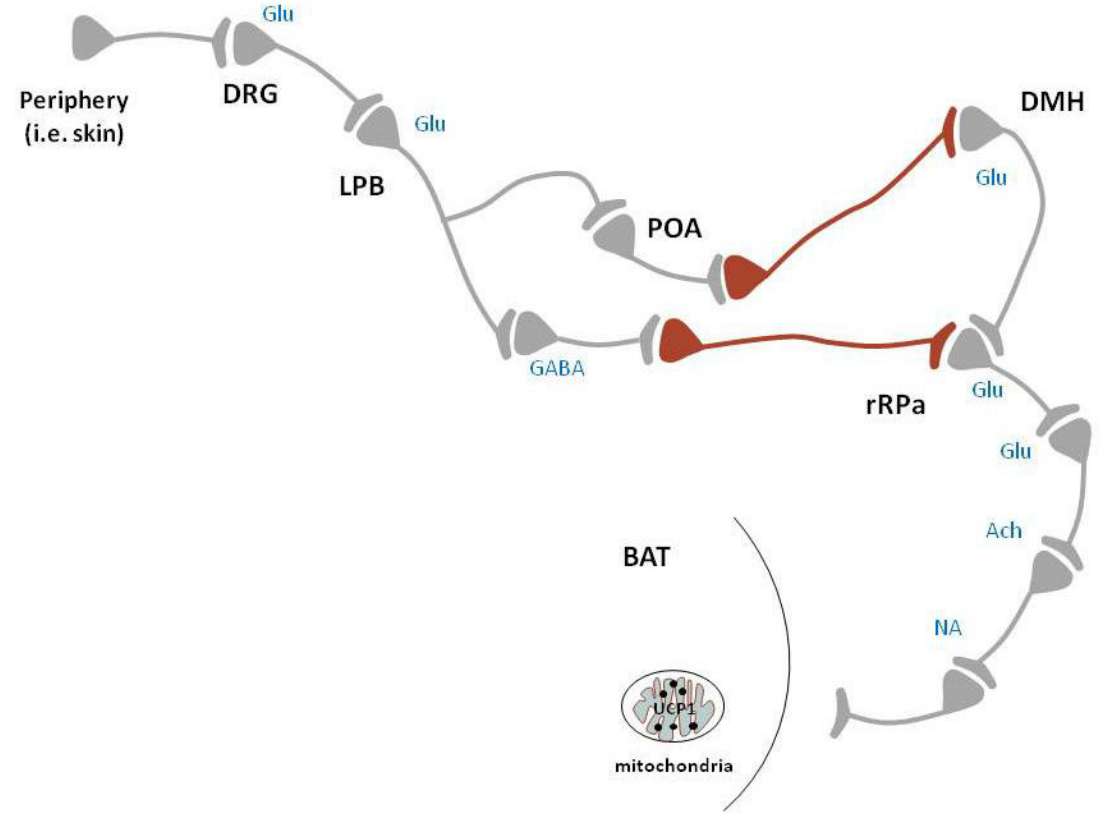
FIGURE 4. Schematic representation of the neuronal pathways involved in temperature regulation and the fever response. Cold-, warm-, and pyrogen-sensitive GABAergic projection neurons (highlighted in red) are part of a neuronal pathway that receives information about peripheral temperature and can regulate fever response by activating thermogenesis in BAT via UCP1. These neurons show the same changes in activity upon cold signals and pyrogens. Abbreviations: BAT, brown adipose tissue; DMH, dorsomedial hypothalamus; DRG, dorsal root ganglion; LPB, lateral parabrachial nucleus; POA, preoptic area, rRPA, rostral raphe pallidus. Glu, glutammate; GABA, gamma amino butyric acid; Ach, acetylcholine; NA, noradrenaline; UCP1, uncoupling protein